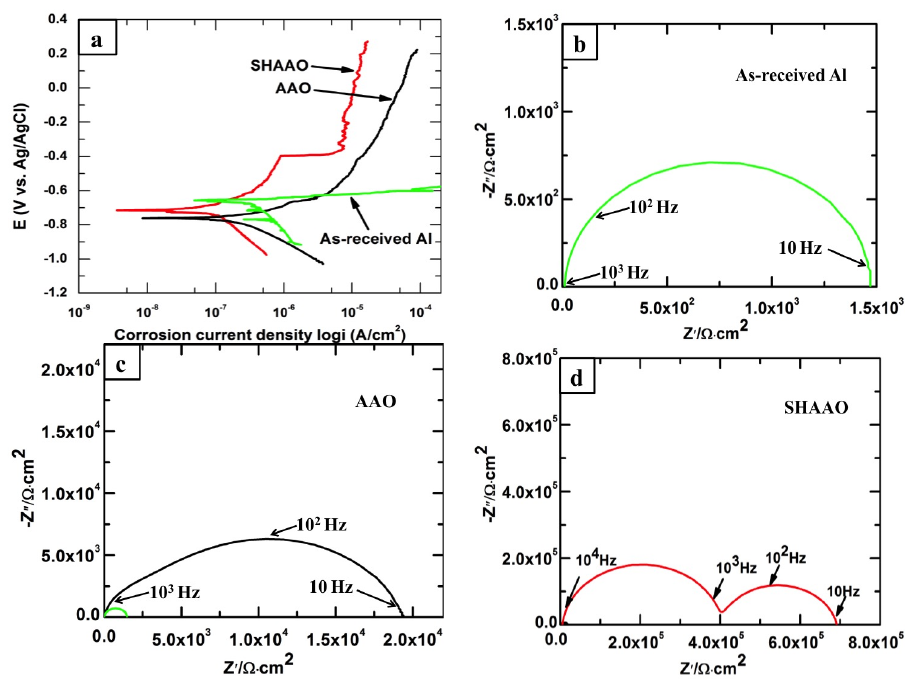
Figure 4. ( a ) Polarization curves of the as ‐ received aluminum alloy, AAO and SHAAO substrates in 3 wt. % NaCl corrosive solution; ( b – d ) the Nyquist plots of ( b ) as ‐ received aluminum alloy, ( c ) AAO (as ‐ received aluminum alloy (a small semicircle in green close to the origin) also shown for comparison) and ( d ) SHAAO substrate (as ‐ received aluminum alloy and AAO also shown inside for comparison, very small semicircle, nearly visible, close to the origin).